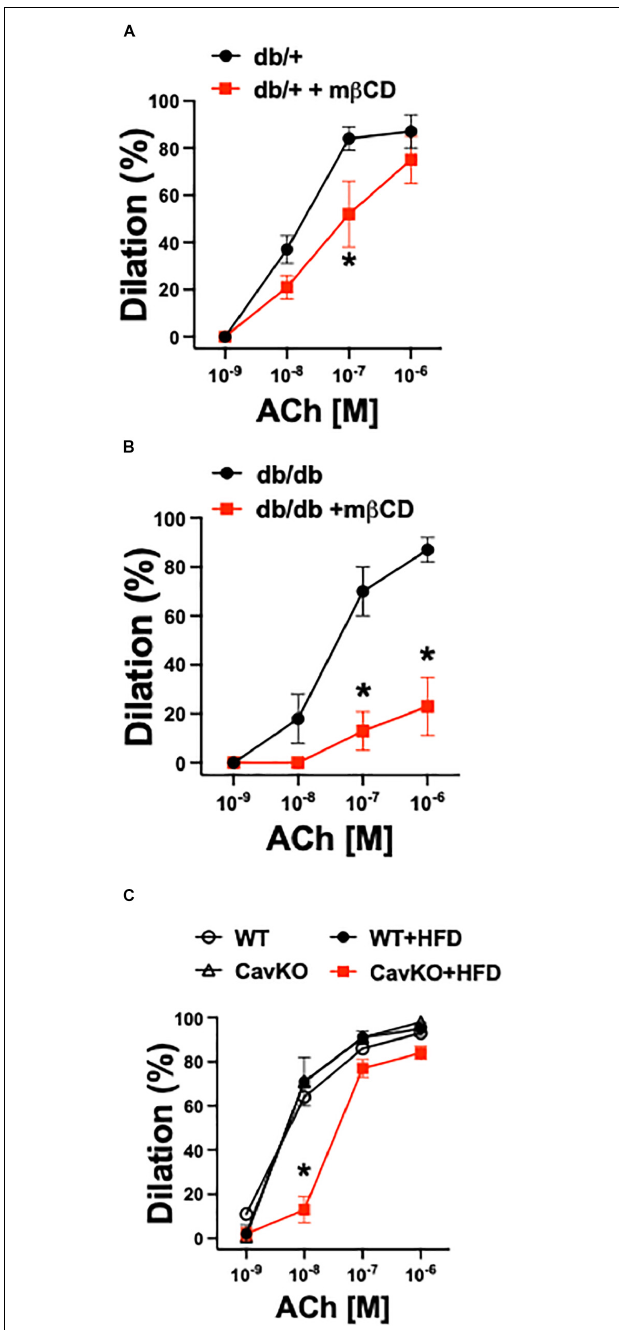
FIGURE 3 | Role of caveolae in arteriole dilation in mouse T2D models, ex vivo . Summary data of percent diameter changes of skeletal muscle arterioles from non-diabetic, heterozygote control (db +) ( n = 6–7) (A) and diabetic (db/db) ( n = 6–7) (B) mice in response to cumulative concentrations of acetylcholine (ACh, 10 − 9 to 10 − 6 M) before and after incubation with methyl- β -cyclodextrin (m β CD, 2 × 10 − 3 M) for 60 min. * p < 0.05 before vs. after m β CD. (C) Summary data of percent diameter changes of skeletal muscle arterioles from normal chow diet or HFD fed Cav-1 knockout (CavKO, n = 4) and wild type (WT, n = 4) mice in response to cumulative concentrations of acetylcholine (ACh, 10 − 9 to 10 − 6 M). * p < 0.05 HFD CavKO vs. WT, Cav-1 KO and HFD WT